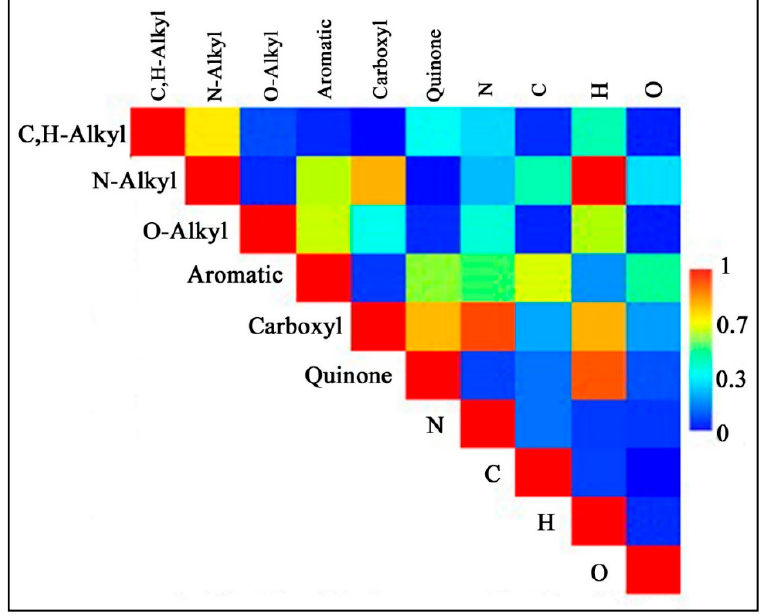
Figure 6. Spearman’s correlation matrix of HA fractions and biogenic elements.